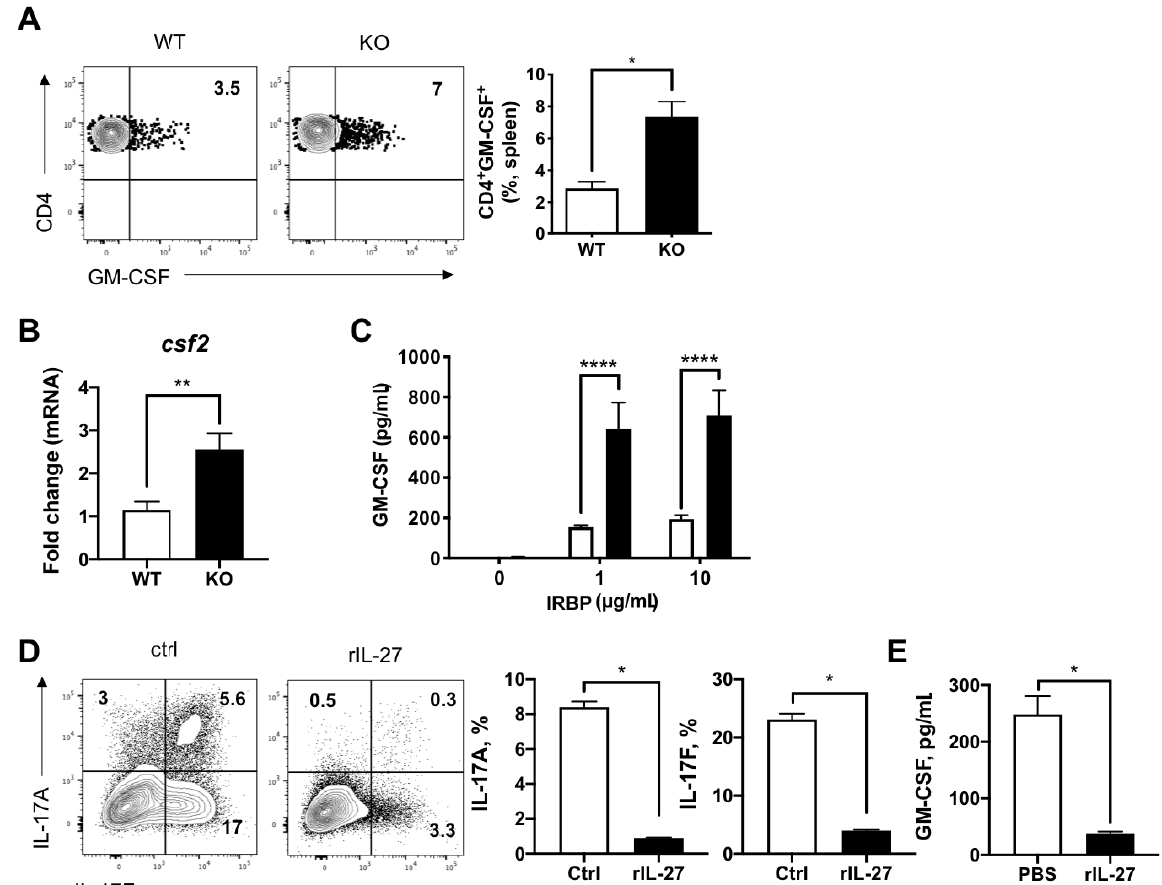
Figure 5. Production of GM-CSF increased in IL-27Ra − / − EAU mice. ( A ) Representative plots and frequency of GM-CSF- producing CD4 + T cells in the spleens from WT and KO EAU mice. Data represent the means ± SEMs of two experiments (WT: n = 5 mice; KO: n = 7 mice). * p < 0.05, Mann–Whitney U test. ( B ) The relative gene expression of csf2 in CD4 + T cells sorted from the spleens of WT and KO EAU mice. Total RNA was extracted from CD4 + T cells that were sorted from the spleens of EAU mice on day 21 post-immunization. Data represent the means ± SEMs from a representative of two experiments (4 mice per group). ** p < 0.01, Mann–Whitney U test. ( C ) Retinal antigen-specific GM-CSF production in dLNs of WT and KO EAU mice. Lymphocytes were isolated from dLNs and stimulated with IRBP for 48 h. Cultured supernatants were collected for cytokine determination by ELISA. Data represent the means ± SEMs of two experiments (WT: n = 5 mice; KO: n = 6 mice). **** p < 0.0001, two-way ANOVA. ( D , E ) CD4 + CD62L + naïve T cells were purified and polarized under Th17 condition with aCD3/CD28 antibodies in the presence of recombinant IL-27 protein for 3 days. For Th17 polarization, culture media were supplemented with IL-6 (25 ng/mL), TGF- β (2.5 ng/mL), anti-IFN- γ (10 µ g/mL), and anti-IL-4 (10 µ g/mL) antibodies. ( D ) Representative FCM plots and frequency of IL-17A and IL-17F expression in CD4 T cells are shown. ( E ) GM-CSF in the cultured supernatants was determined by ELISA at the same time. Data represent the means ± SEMs of three combined experiments. * p < 0.05, two-way